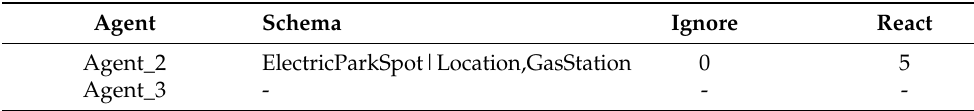
Table 1. Qmatrix of the agents after the first query (syntactic version).